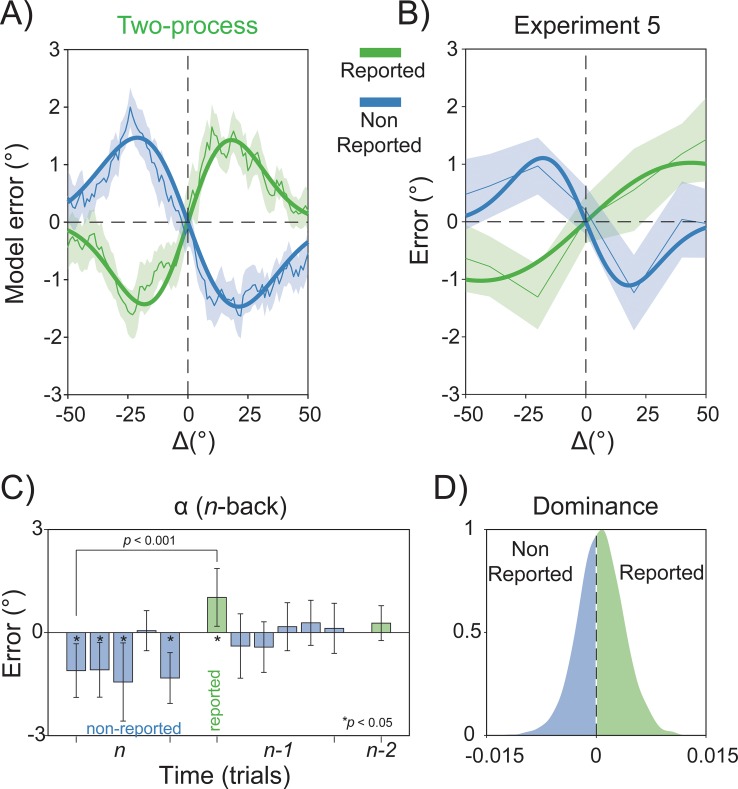
Opposite effects of previous stimuli and decisions on perception.(A–B) In excellent agreement with the predictions of the Two-process model (A), the observed results of Experiment 5 (B) revealed the opposite effects of previous stimuli (nonreported) and perceptual decisions (reported) on current perception. (C) Almost all stimuli in the last nonreported sequence exerted a repulsive effect. (D) In the context of this experiment, where past decisions and stimuli were orthogonal, opposite biases from previous decisions and sensory signals dominated single perceptual reports with almost equal contribution. The raw data are available at https://doi.org/10.5281/zenodo.2544946.